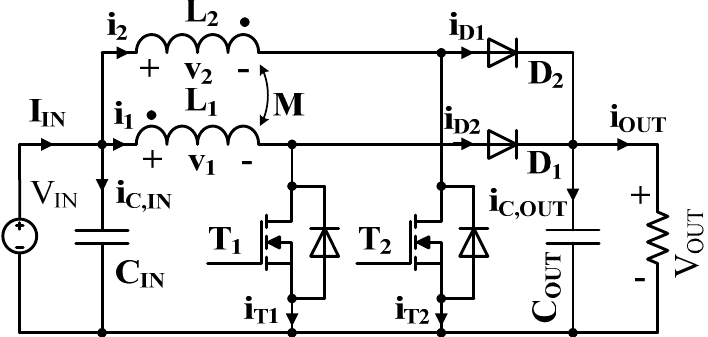
Figure 1. Standard dual interleaved boost converter with coupled inductors.